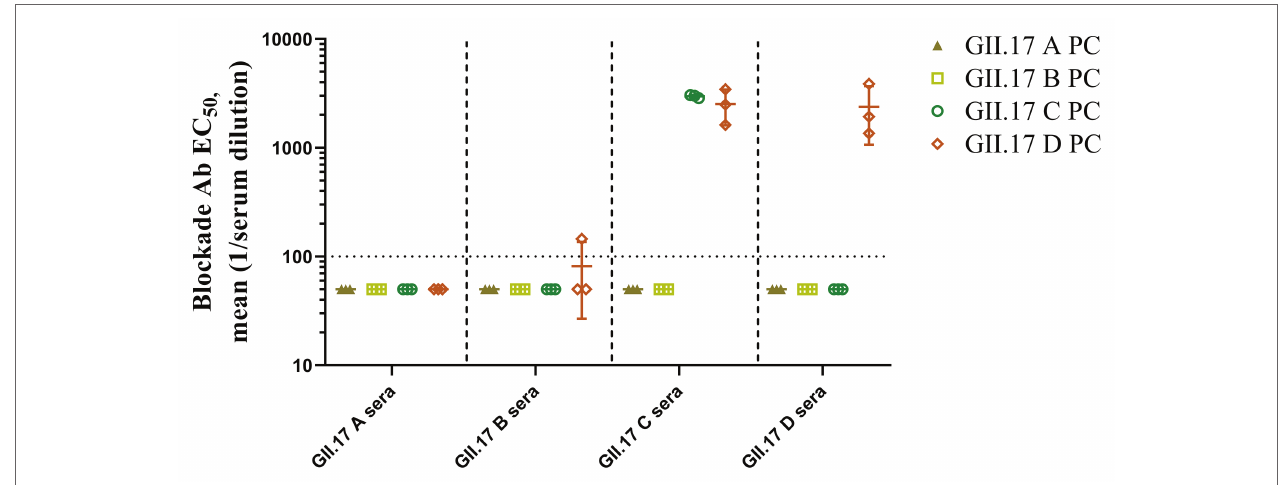
FIGURE 6 | GII.17 type-specific and cross-reactive blockade antibodies. Sera from mice immunized with GII.17 P particles were evaluated for the ability to block P particle binding with carbohydrate ligand pig gastric mucin type III (PGM). The results are represented in log10 antibody titers. EC 50 , half-maximum effective concentration. Bars represent the geometric mean titer (GMT). Dotted line equals the assay limit of